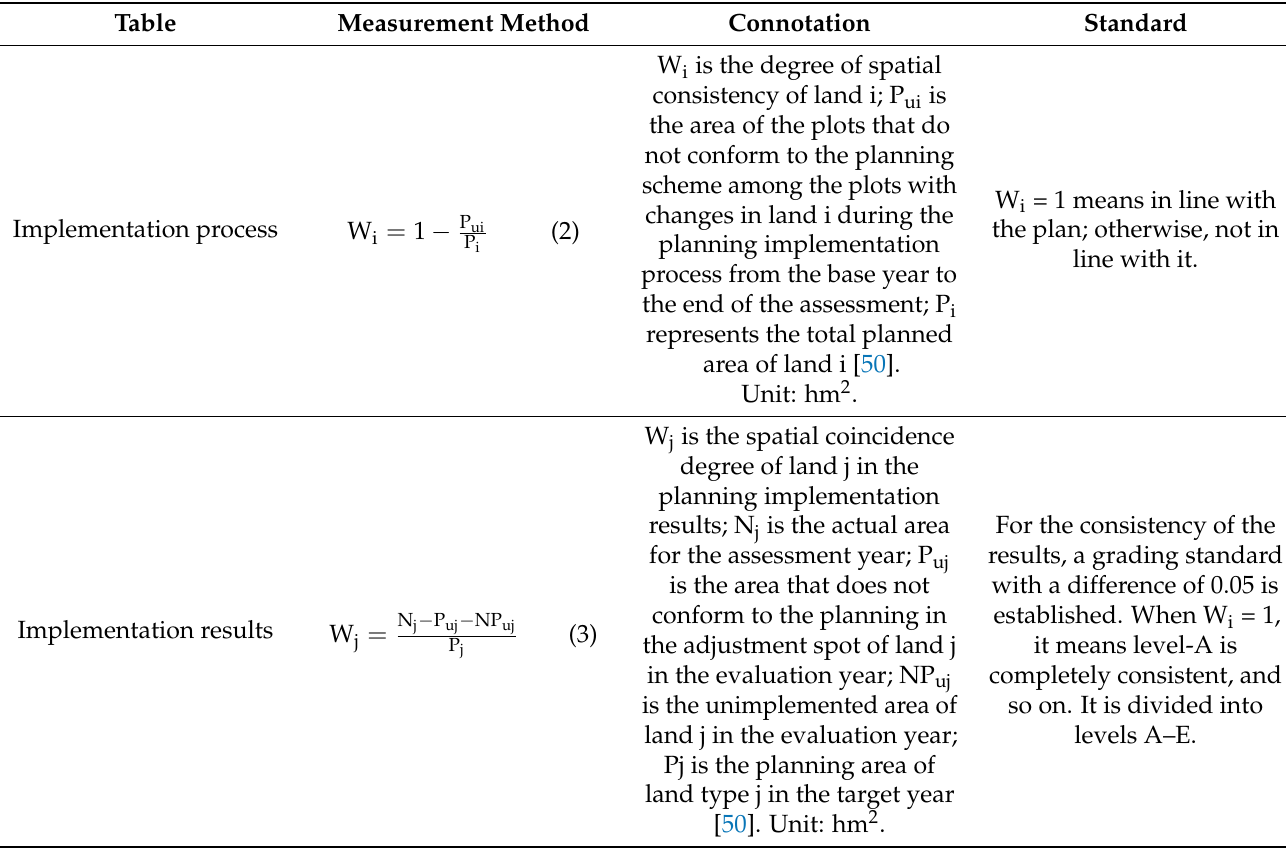
Table 3. Method and connotation of the spatial fit measurement model. Table Measurement Method Connotation Standard